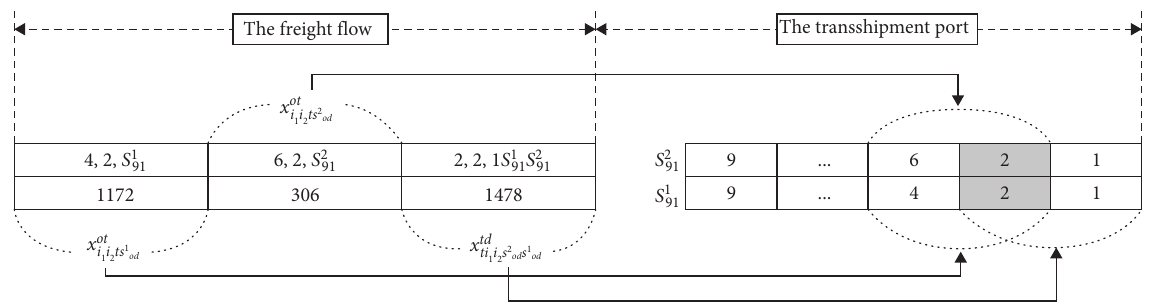
Figure 3: A typical solution to model